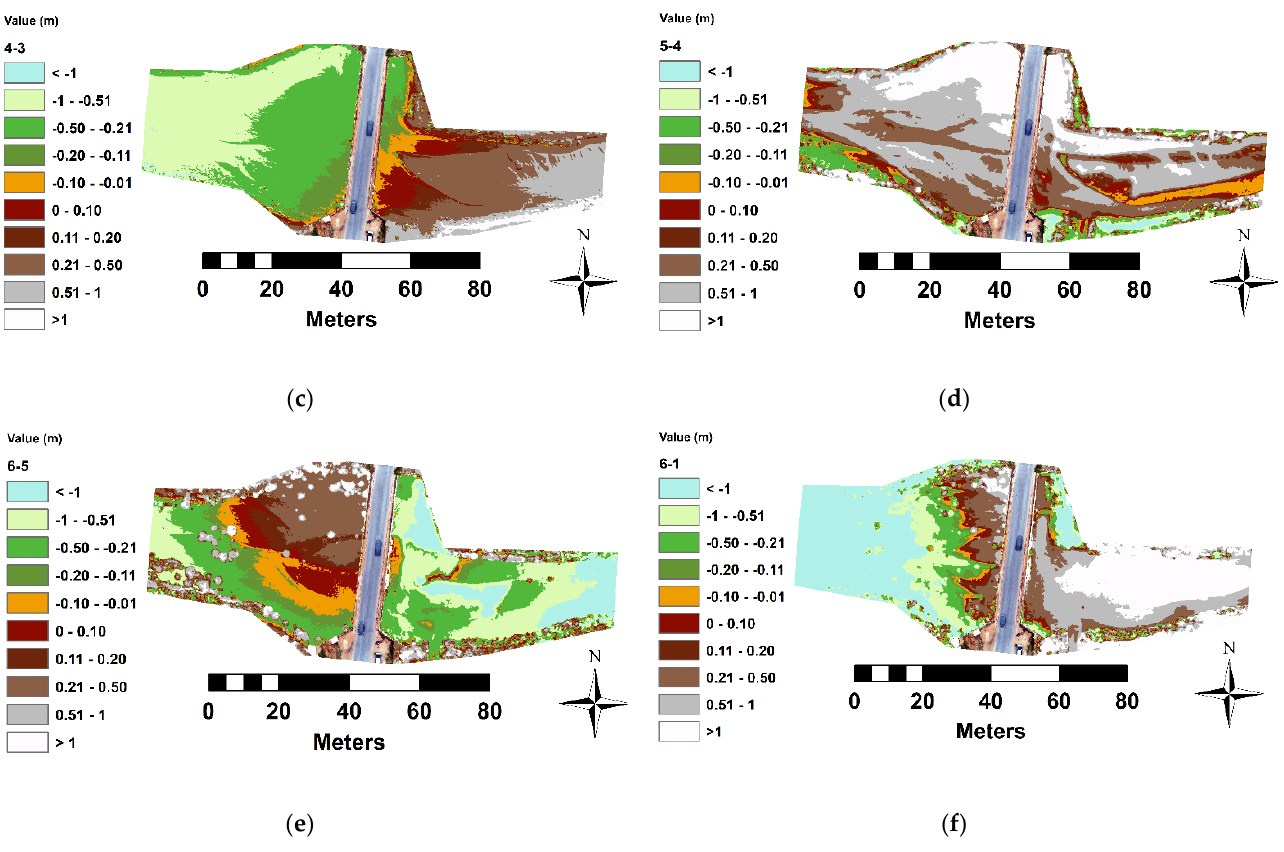
Figure 9. The produced DoDs extracted when comparing the DSMs for different flights: ( a ) 2 – 5 Jan-